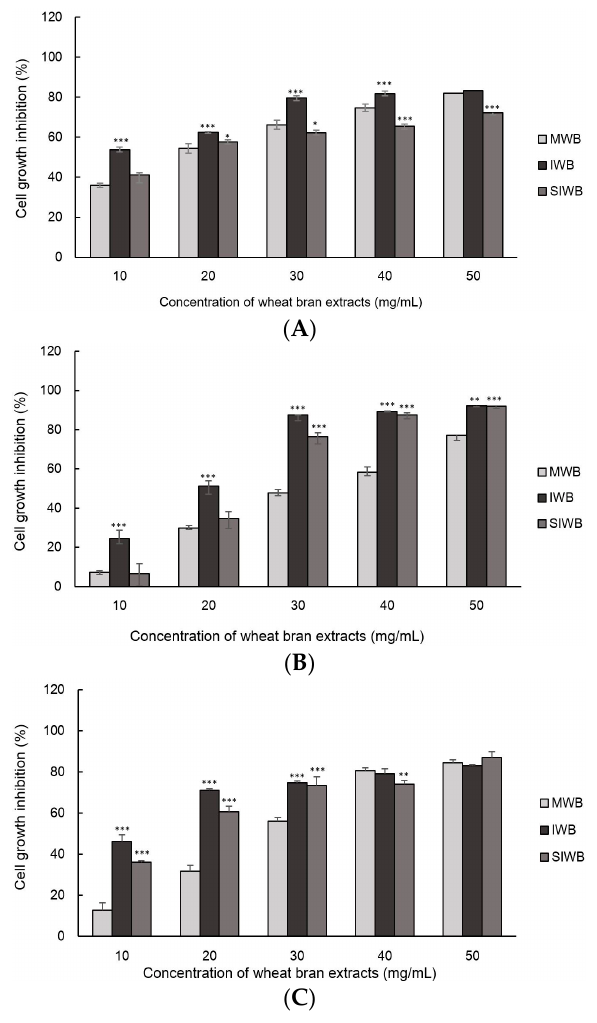
Figure 1. The cell growth inhibition of ( A ) Caco-2; ( B ) HT-29; and ( C ) HeLa cells treated with mature wheat bran (MWB), immature wheat bran (IWB), and steamed immature wheat bran (SIWB) extracts. * p < 0.05, ** p < 0.01, *** p < 0.001 vs. MWB at each concentration of wheat bran extracts.